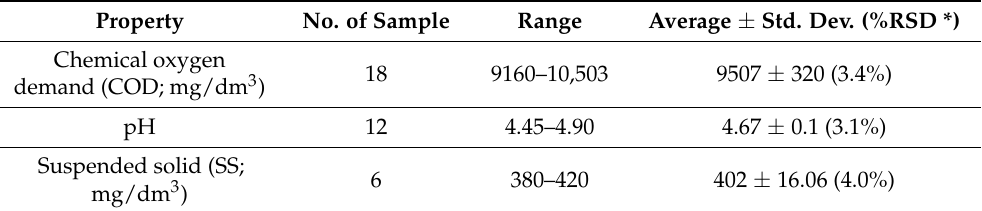
Table 2. Characteristics of the studied dyeing wastewater with the sampling time and some statistics. Property No. of Sample Range Average ± Std. Dev. (%RSD